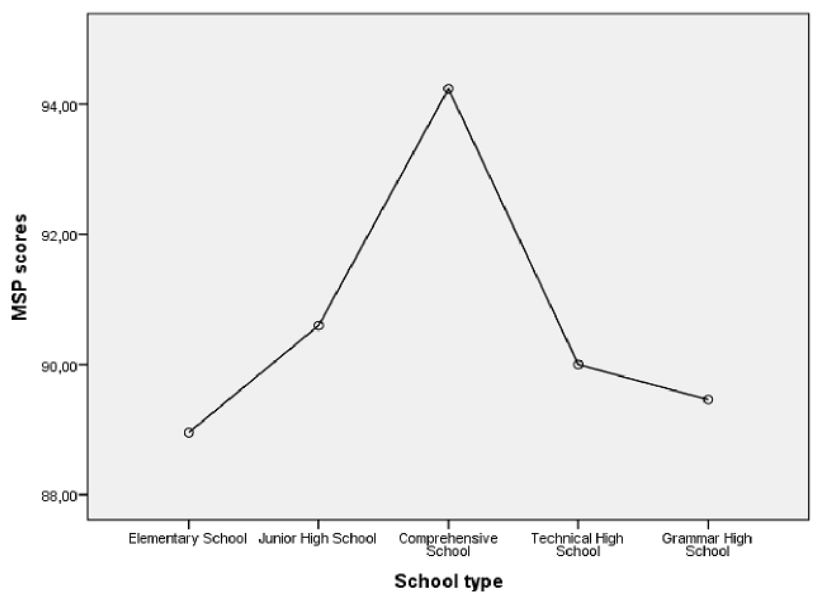
Figure 1. Type of School and Stress for the Principal.